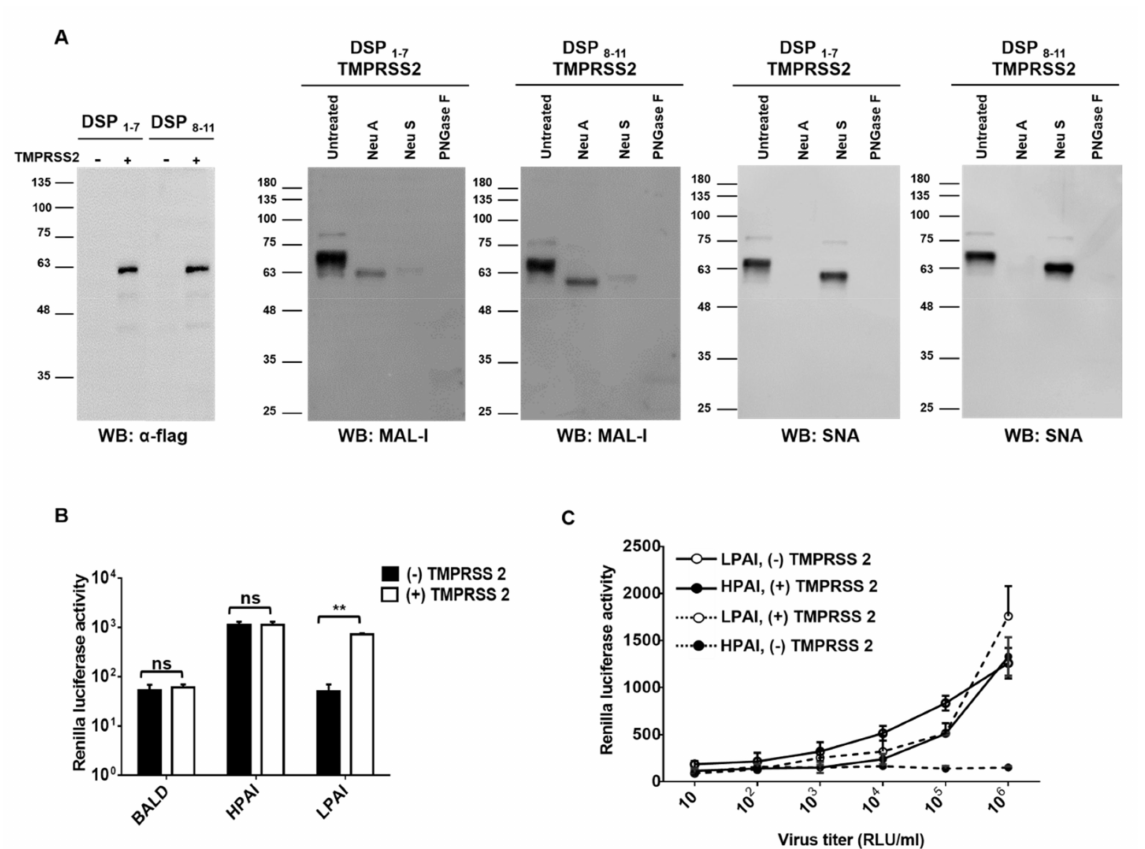
Figure 3. Additional proteases induced LPAI-mediated nanoparticle fusion. ( A ) Nanoparticles expressing DSPs, sialic acids, and TMPRSS2 were grown in HEK293T cells and incubated with neuraminidase A (Neu A), neutraminidase S (Neu S), or PNGase F for 18 h at 37 ◦ C. Sialic acids expressions were detected using biotinylated SNA or biotinylated MAL-1. TMPRSS2 expression was detected using anti-flag antibody. ( B ) Nanoparticles expressing DSPs, sialic acids, and/or TMPRSS2 were incubated with HPAI, LPAI, or BALD pseudotyped viruses for 1 h at 4 ◦ C. ( C ) HPAI and LPAI pseudotyped viruses were 10-fold serially diluted and then incubated with nanoparticles for 1 h at 4 ◦ C. In all experiments, mixtures were adjusted at pH 5.0 and incubated with RL substrate for 10 min. Nanoparticle fusion was quantified by measuring RL activity. Error bars present SD from the mean ( n = 3). Statistical significance was assessed by Student’s t test. **, p < 0.01; ns, not